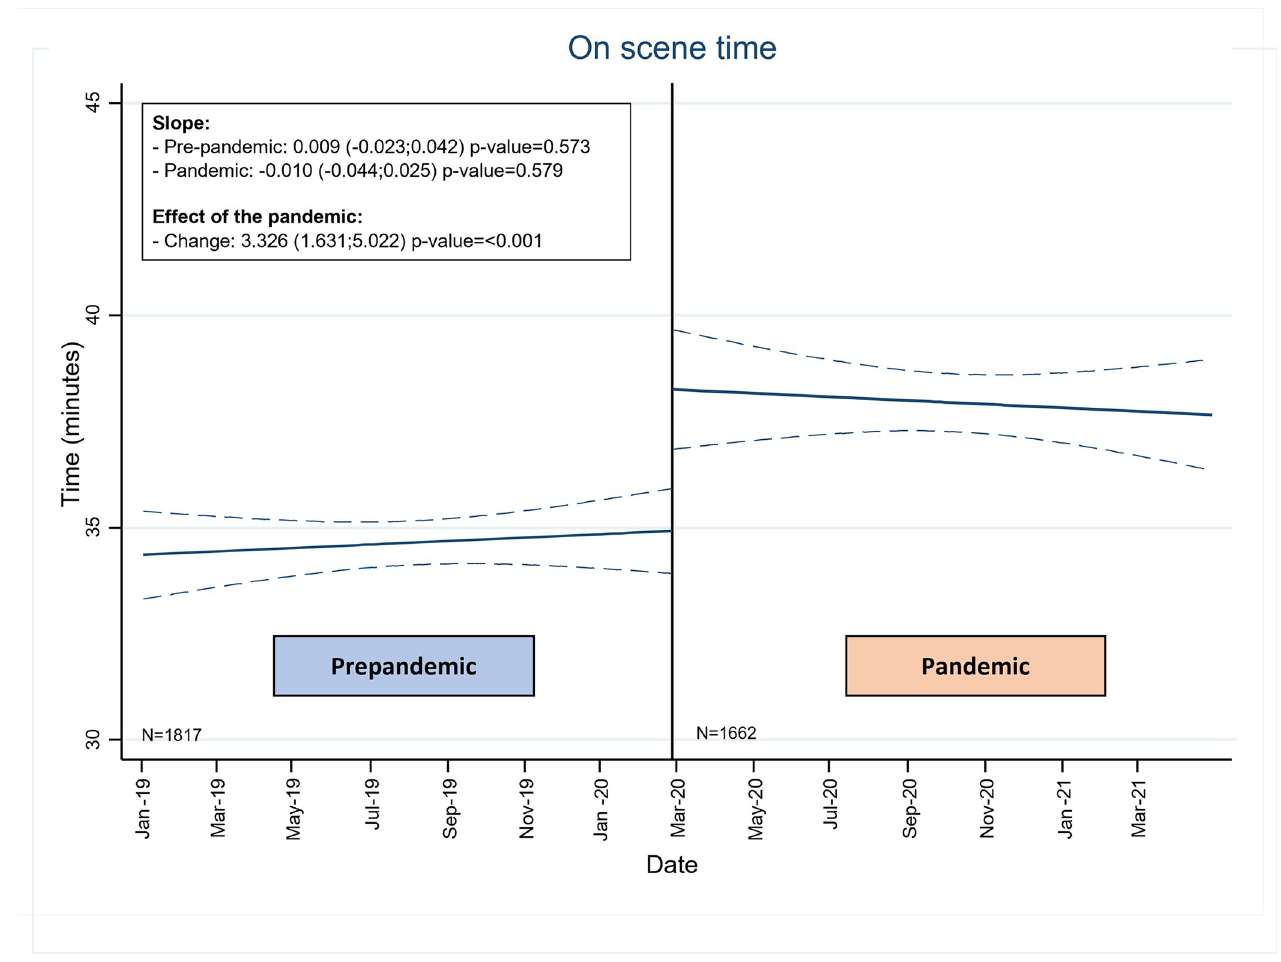
Fig 4. Interrupted time series with the “on-scene” time of SUMMA